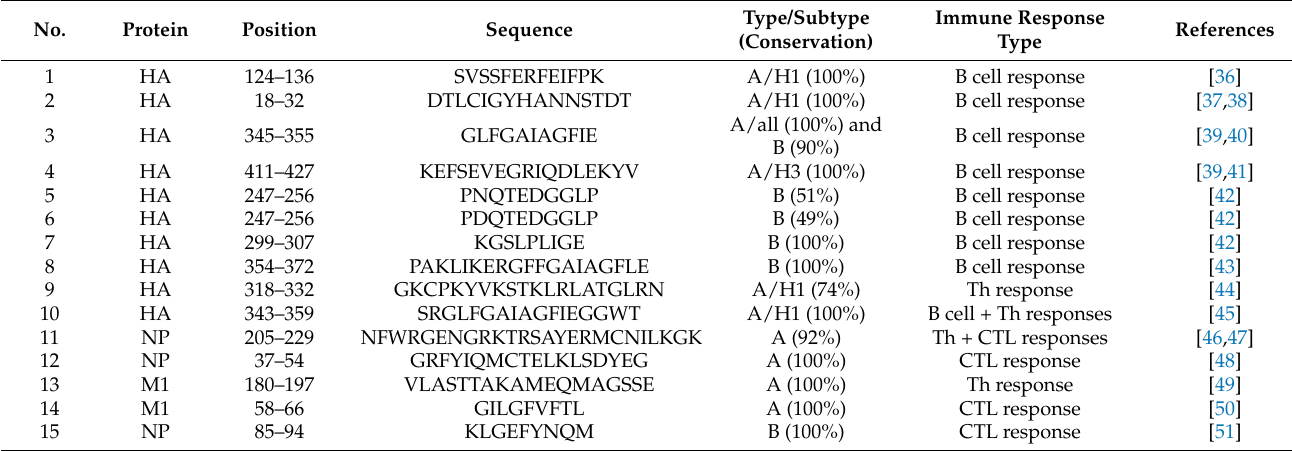
Table 1. Conserved immunogenic influenza virus epitopes selected from the IEDB